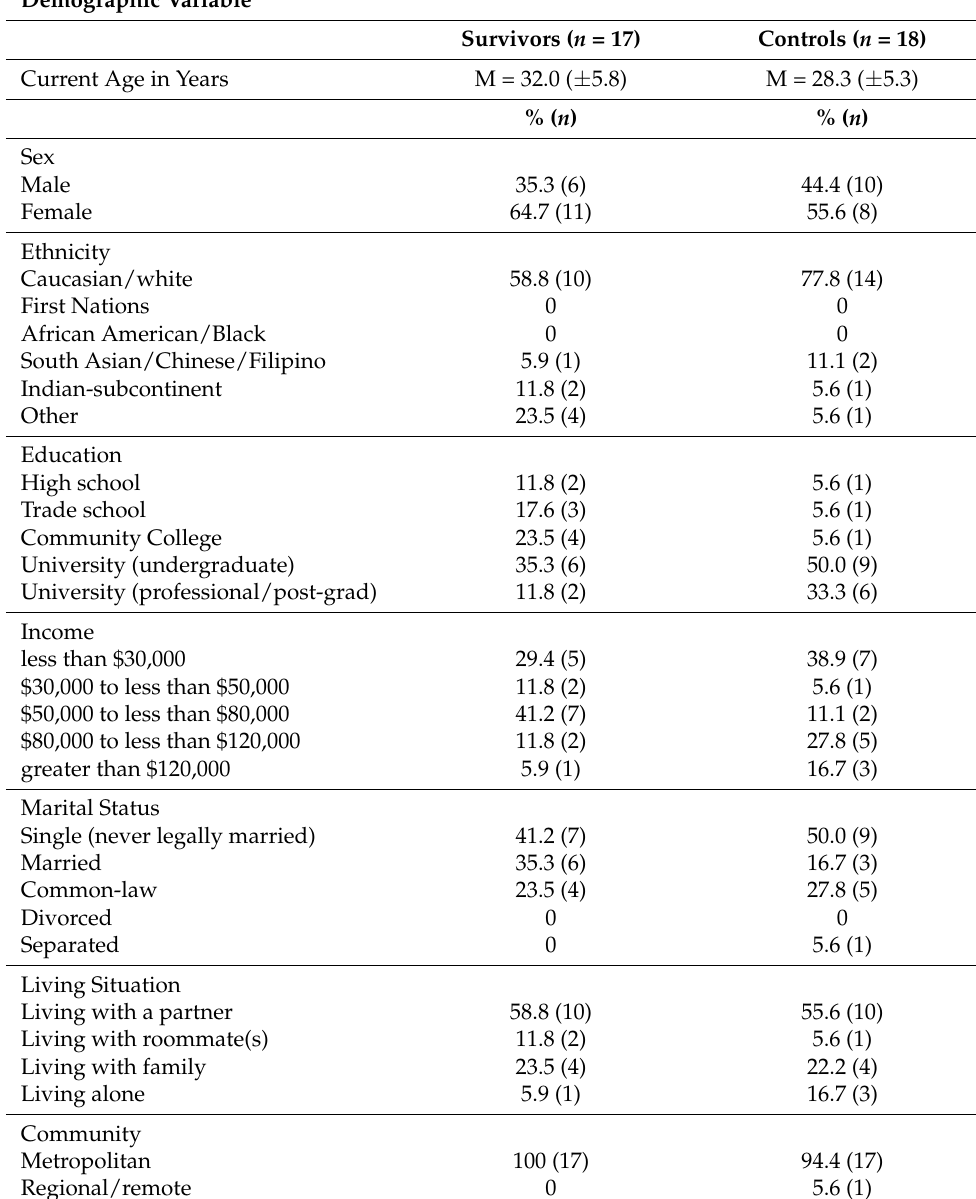
Table 1. Demographic characteristics of study participants ( N =